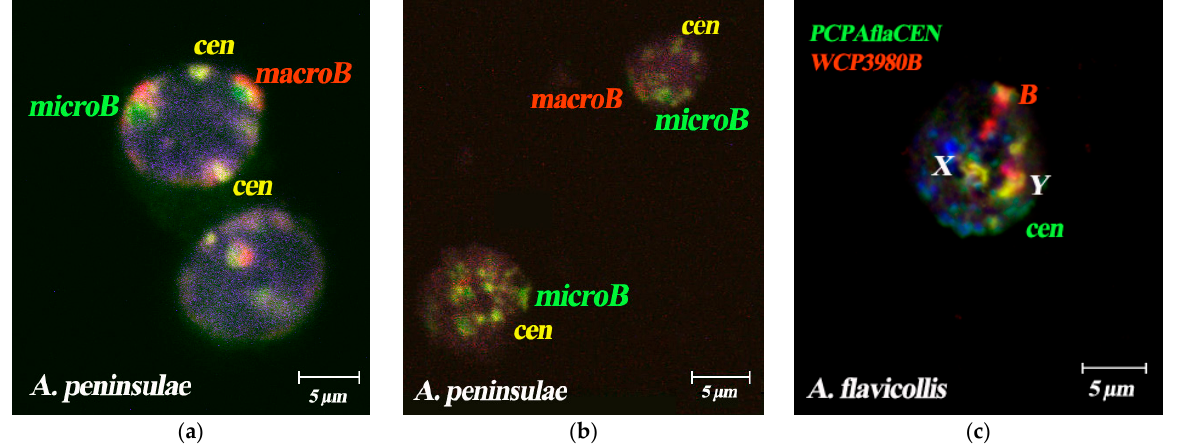
Figure 7. Maximum intensity projection of laser scanning microscopy through Apodemus peninsulae ( a , b ) and A. flavicollis ( c ) interphase nucleus with the Bs and centromere FISH signals. ( a , b ) Section showing association of B arm specific repeats type 1 (“ macro ” B, middle size, red), B arm specific repeats type 2 (“ micro B ”, small size, green) and pericentromeric regions (“ cen ”, yellow) in the interphase nuclei of spermatocytes of A. peninsulae specimen # 5 (male with 6B, Novosibirsk region, Russia) and A. peninsulae specimen # 9 (male with micro-6B, Krasnoyarsk district, Russia); ( c ) S-FISH of WCP3980B probe (red signal) and PCPAflaCEN probe (green signal) with the interphase nuclei of bone marrow cells of A. flavicollis male #24448 (1B, Novgorod region, Russia). Bs, X and Y chromosomes are marked by corresponding letters. Nuclei were stained with DAPI (blue).